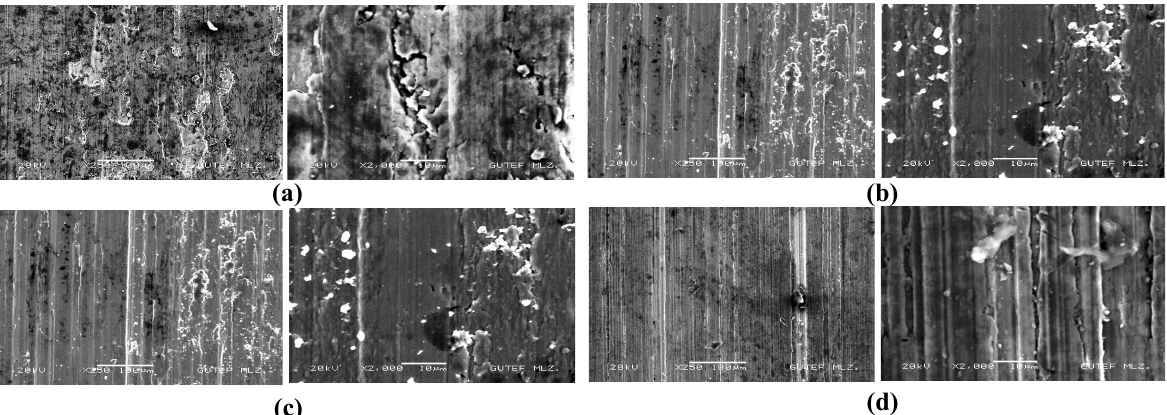
Figure 10. Low ( (cid:2) 250 ) and high ( (cid:2) 2000 ) magnification SEM micrographs of the brasses, which are worn at the 600 m sliding distance, under the 40 N load and at a linear sliding speed of 0.3 m s (cid:3) 1 on the various ductile iron disc. (a) and (b) pearlitic disc, (c) and (d) ferritic disc.